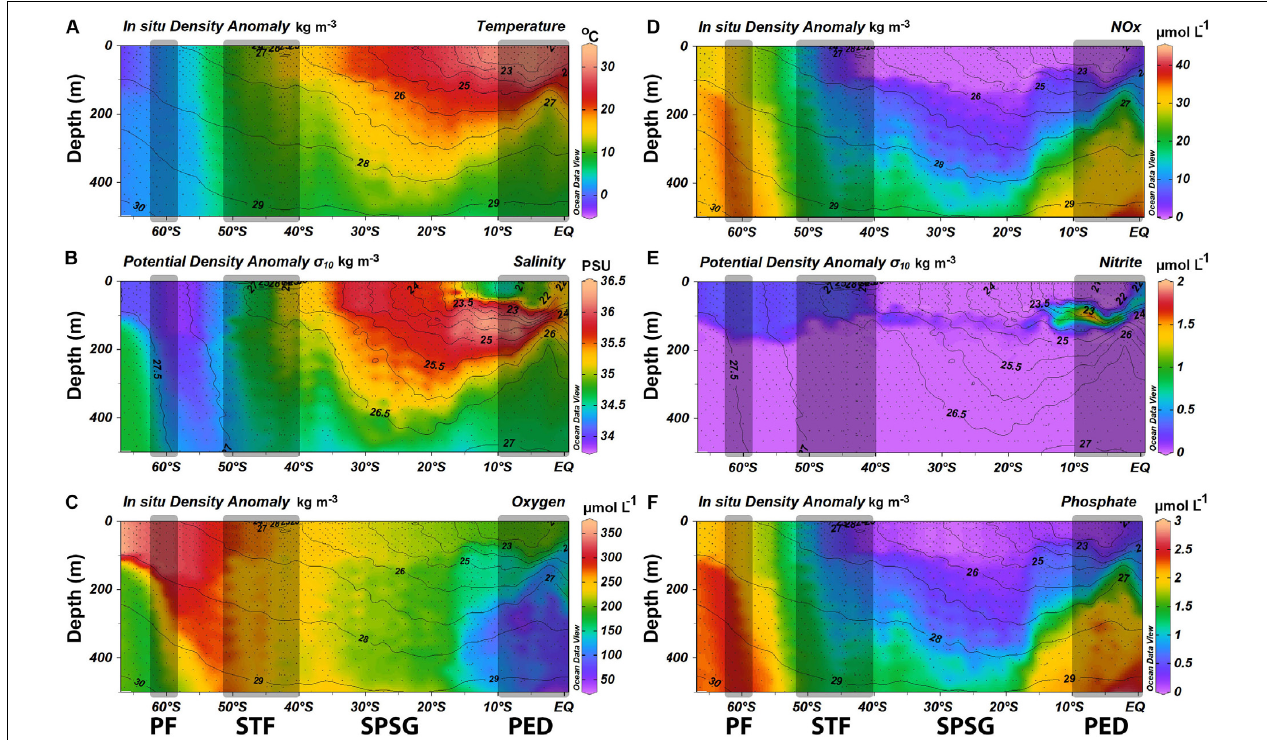
FIGURE 2 | Physical and chemical plots with in situ density anomalies [kg.m − 3 ; plots (A,C,D,F) ] and potential density anomalies [kg.m − 3 ; plots (B,E) ] overlaid as contour lines along the P15S GO-SHIP transect (A) Temperature ( ◦ C) profile from the surface to 500 m, (B) Salinity (PSU) from the surface to 500 m depth, (C) Dissolved oxygen ( µ mol L − 1 ) concentrations from the surface to 500 m depth, (D) Concentrations NO 3 − µ mol L − 1 ) from the surface to 500 m depth, (E) NO 2 − concentrations ( µ mol L − 1 ) from the surface to 500 m depth, and (F) PO 43 − concentrations ( µ mol L − 1 ) from the surface to 500 m depth. Black dots denote sampling depths of 140 CTD stations. Gray rectangles denote oceanographic fronts (PF, Polar front; STF, Subtropical Front; Eq, Equatorial upwelling